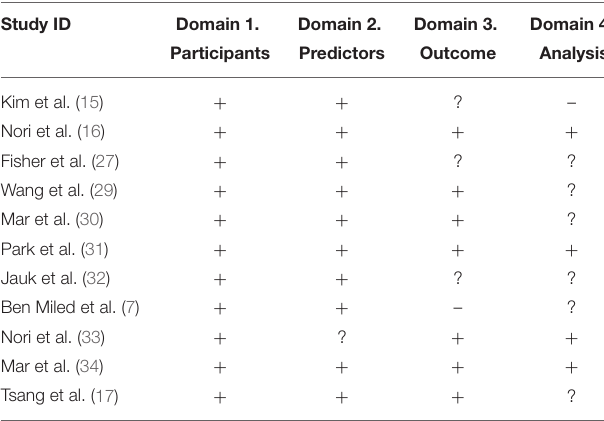
TABLE 2 | Study quality assessment using